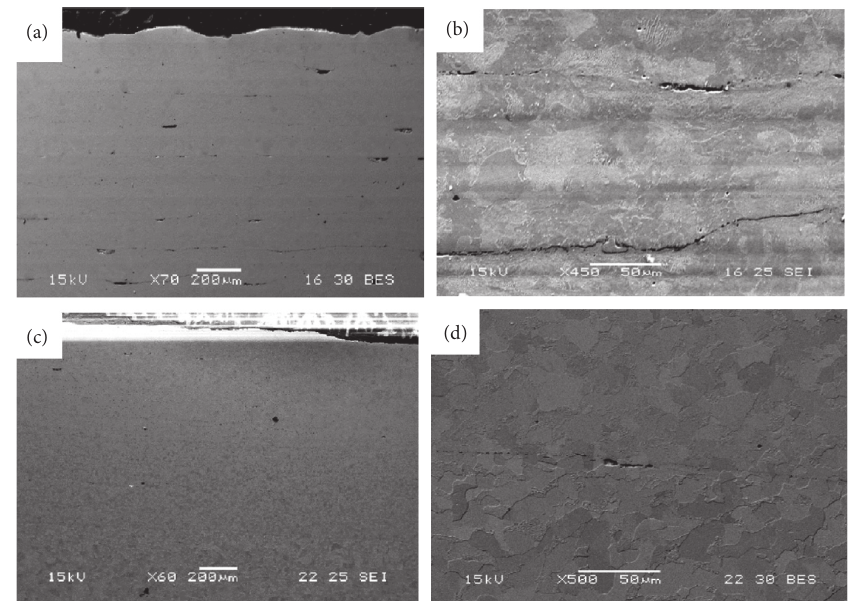
Figure 8: SEM micrographs of 4130 specimen before (a, b) and after (c, d) SPS treatments